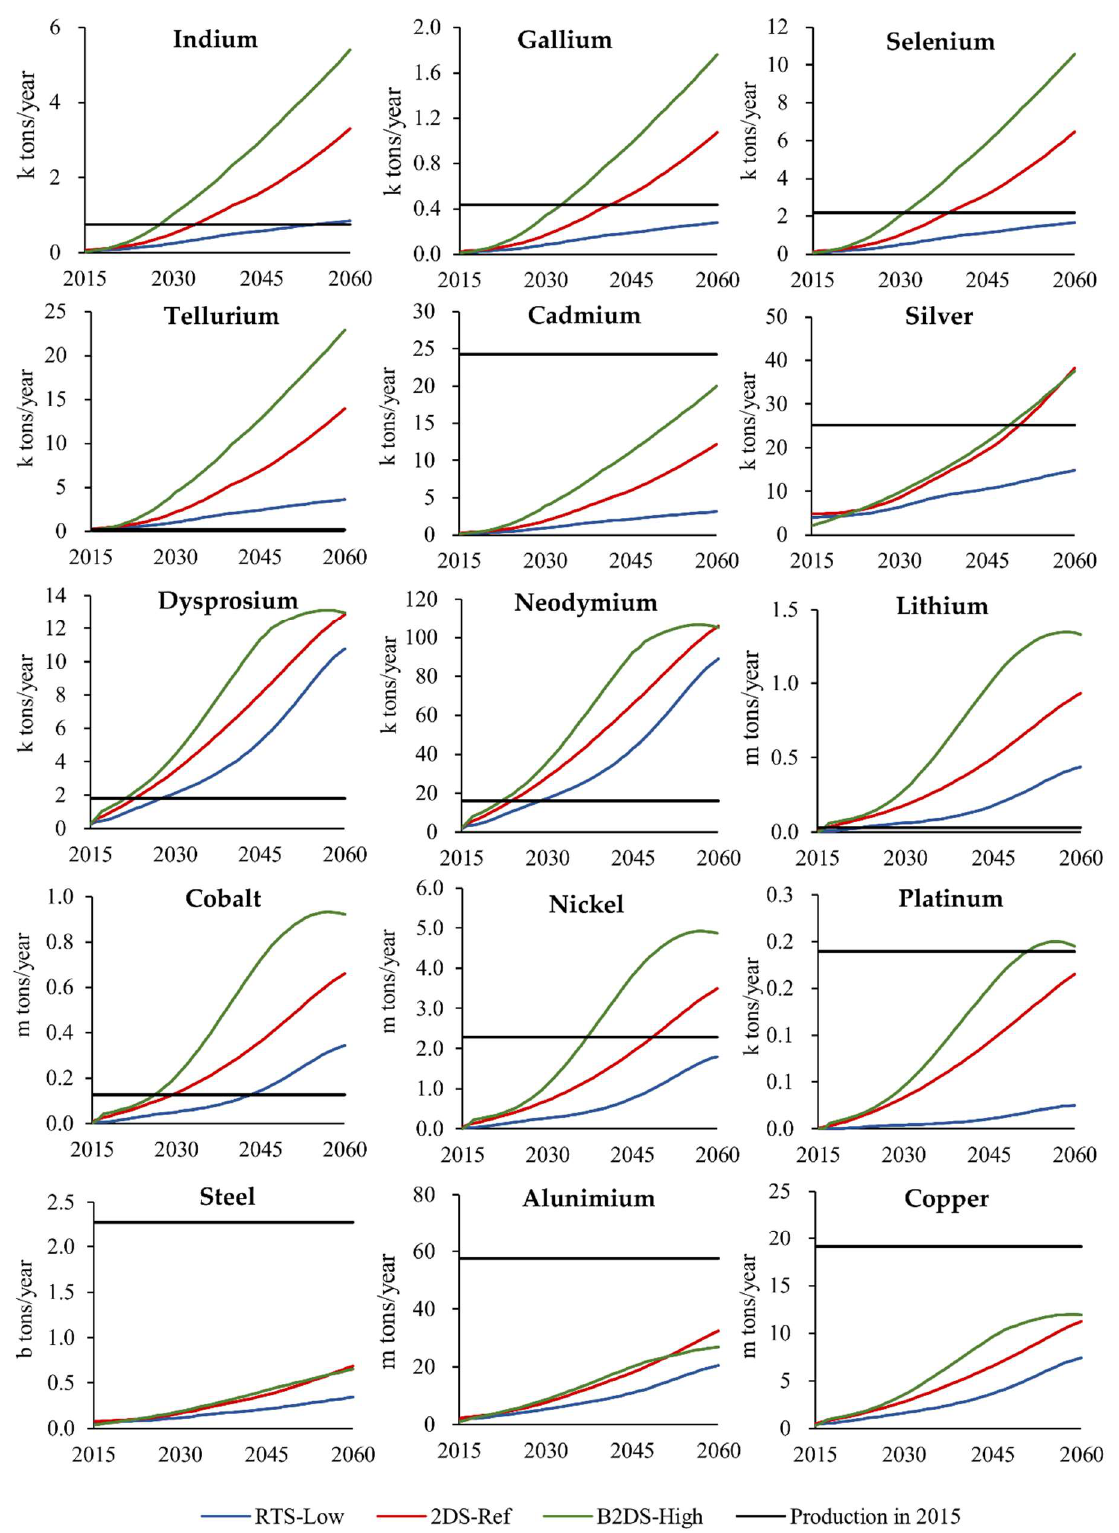
Figure 12. Estimated annual demand for low carbon energy technology up to 2060.